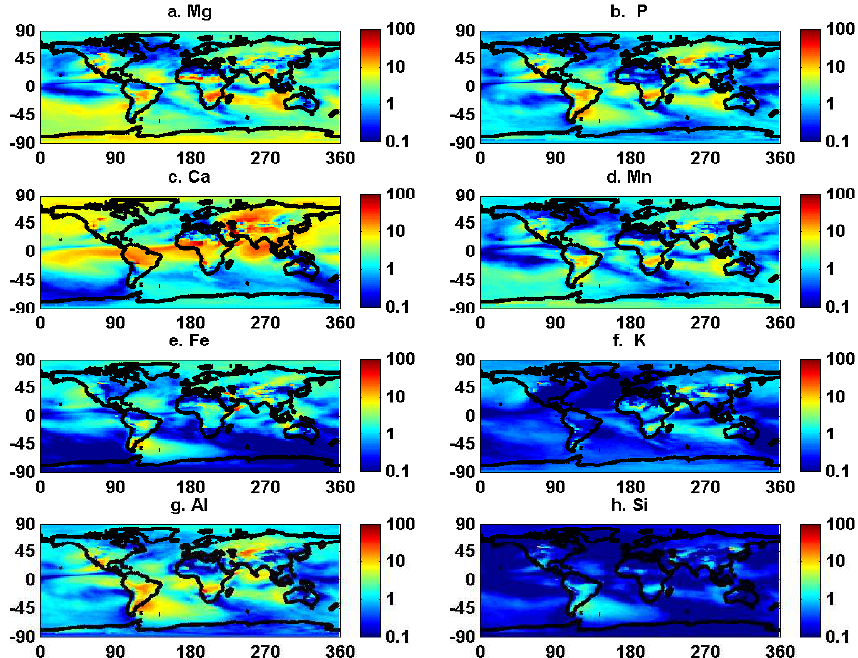
Figure 7. Ten-year monthly variability in mean of elemental percentages in dust deposition (mass %): (a) Mg, (b) P, (c) Ca, (d) Mn, (e) Fe, (f) K, (g) Al, (h) Si. Elemental monthly mean percentages are calculated using the monthly mean emission of each element divided by the monthly mean emission of